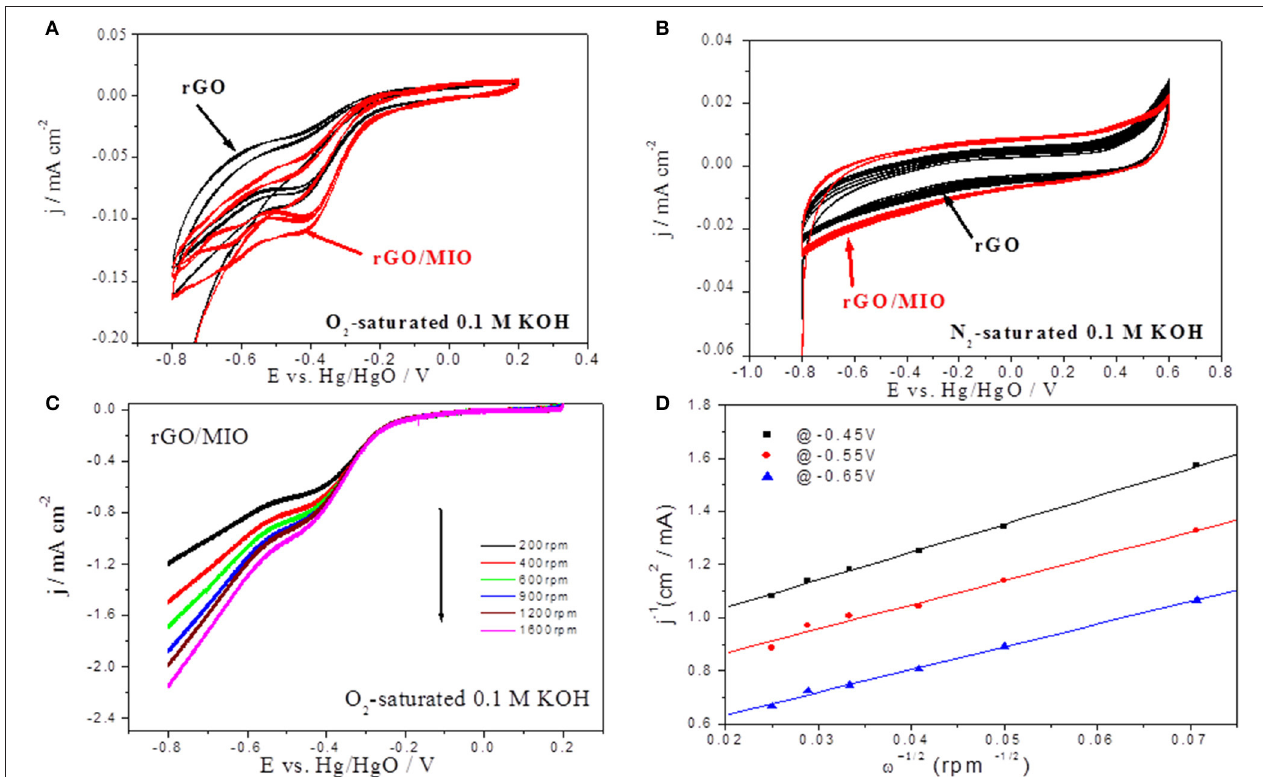
FIGURE 4 | CVs run at 100 mVs − 1 with rGO and rGO/MIO electrodes in (A) O 2 -saturated and (B) N 2 -saturated 0.1M KOH section. (C) Linear scan voltammograms recorded in O 2 -saturated 0.1M KOH at 5mV s − 1 and different rotation rates for ORR on rGO/MIO and (D) the corresponding Koutecky-Levich Plot obtained at three different